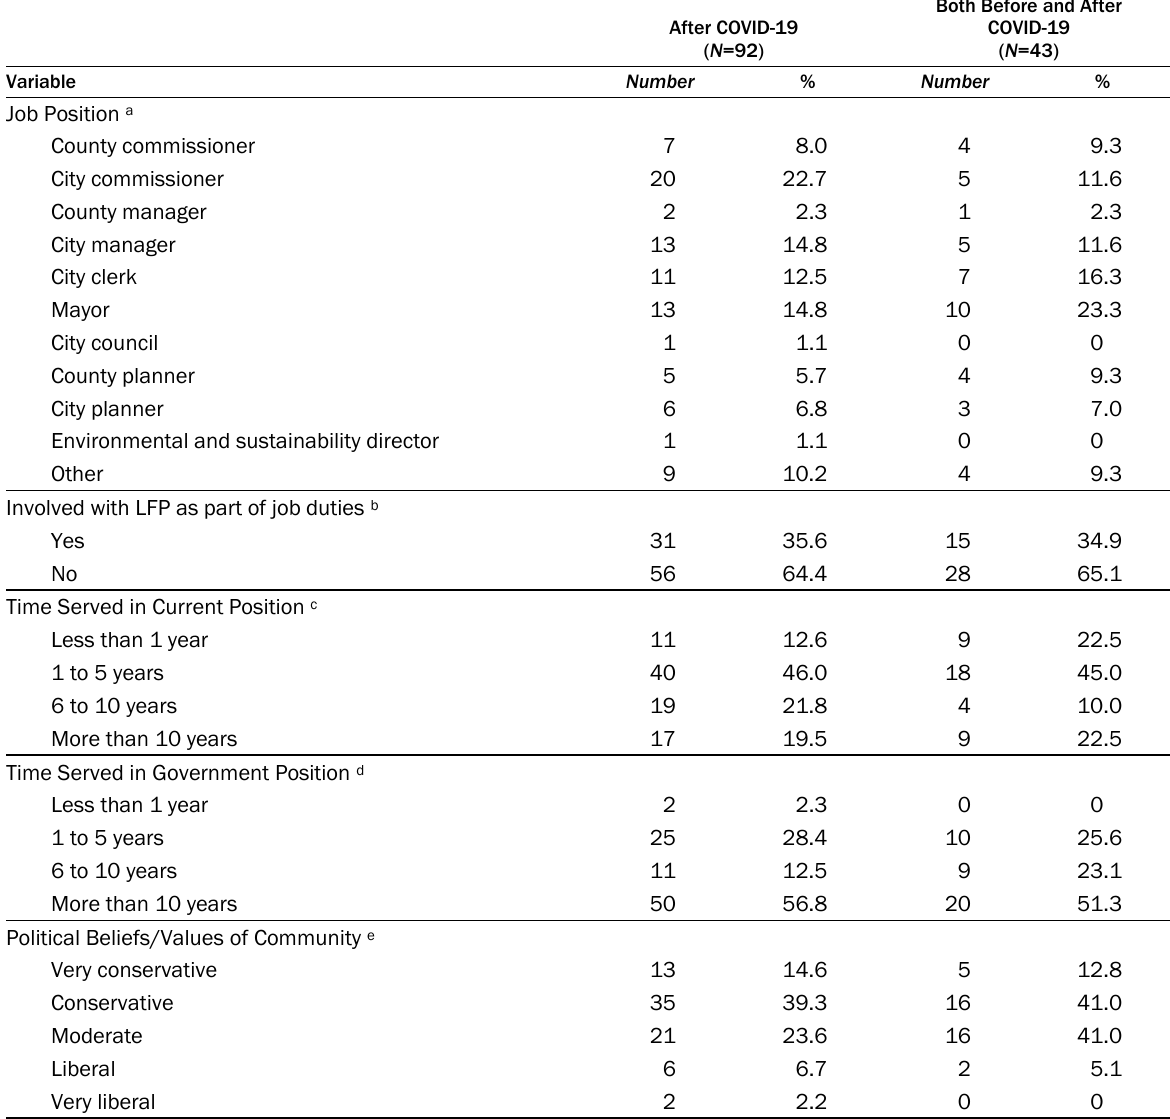
Table 1. Professional Characteristics of Respondents